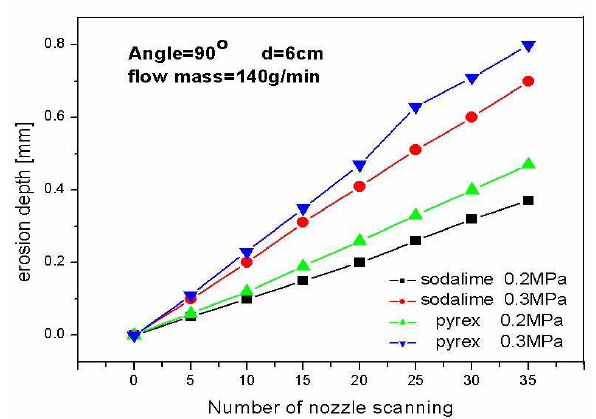
Figure 3. Effects of blasting pressure variation on erosion depth.